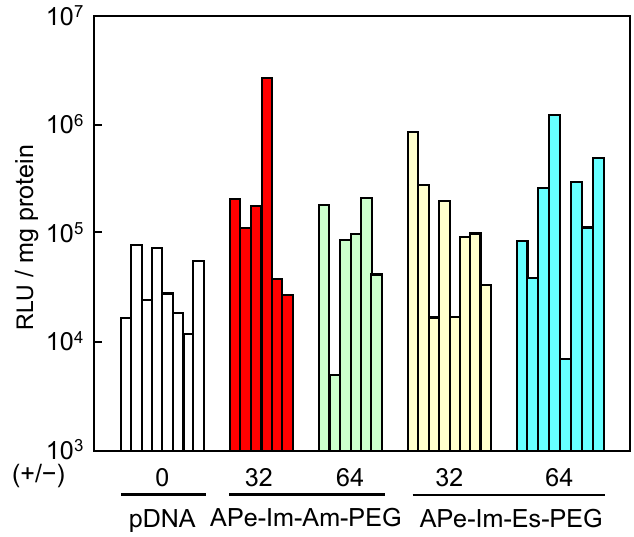
Figure 6. Luciferase gene expression by muscular injection of the APe-Im-Am-PEG/pDNA MIC or APe-Im-Es-PEG/pDNA MIC at [ ω -amide-pentylimidazolium] PEG /[phosphate] pDNA (+/ − ) ratios of 32 and 64. Individual gene expression was determined by relative light unit (RLU) normalized by protein concentration.